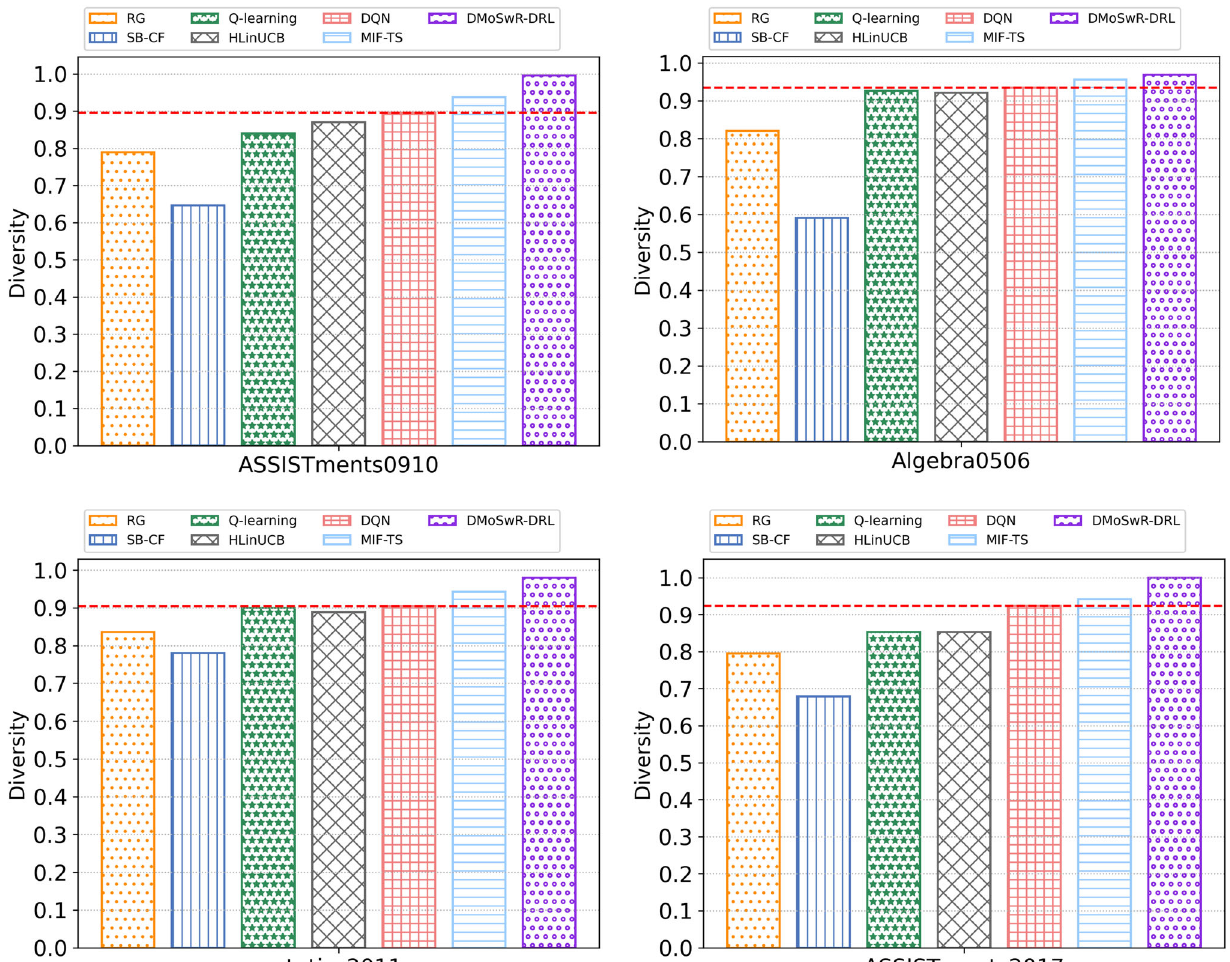
Fig. 10 Performance comparison of different models on four datasets in terms of diversity (red dotted line: